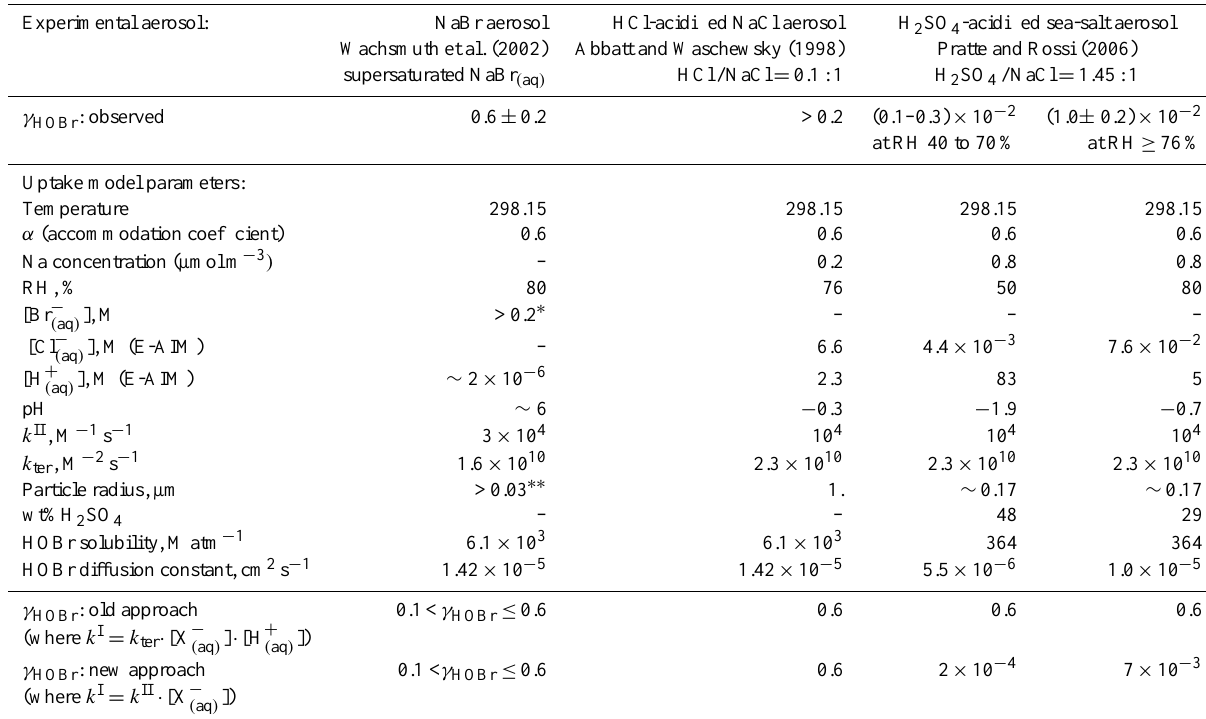
Table 4. Predicted uptake coefficients compared to reported uptake on experimental aerosol. *Br − concentration prior to aerosol dehumidi- fying – reported reduction in volume during dehumidifying indicates actual concentration may be a factor of ∼ 3 higher; **reported modal radius, although particles >0.2µm exist within the size